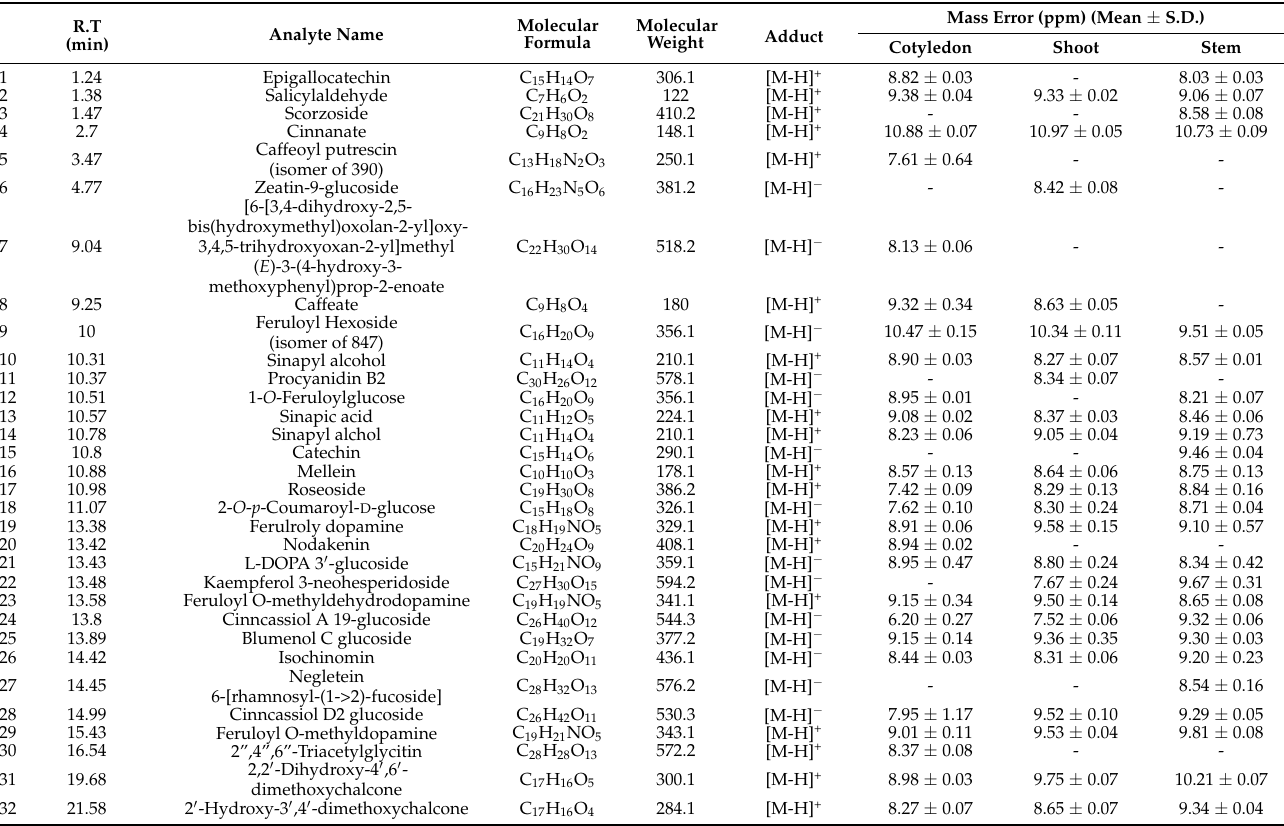
Table 4. Distribution of (tentatively) identified metabolites in different organs of the ice plant ( Mesembryanthemum crystallinum